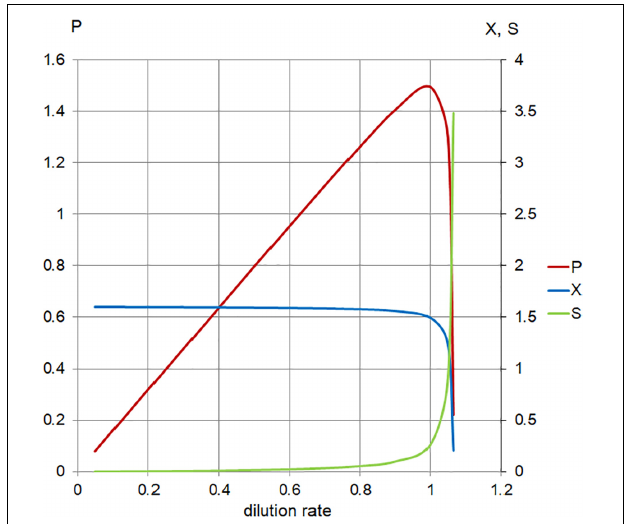
FIGURE 5 | Calculated steady-state values for the model set in Table 1 , Case 1. Concentration of limiting nutrient ( S , green), suspended bacterial biomass ( X , blue), and biomass production ( P, red); left axis, P (arbitrary units/hour); right axis, X , S (arbitrary units); and horizontal axis, dilution rate ( D ; h − 1 ).